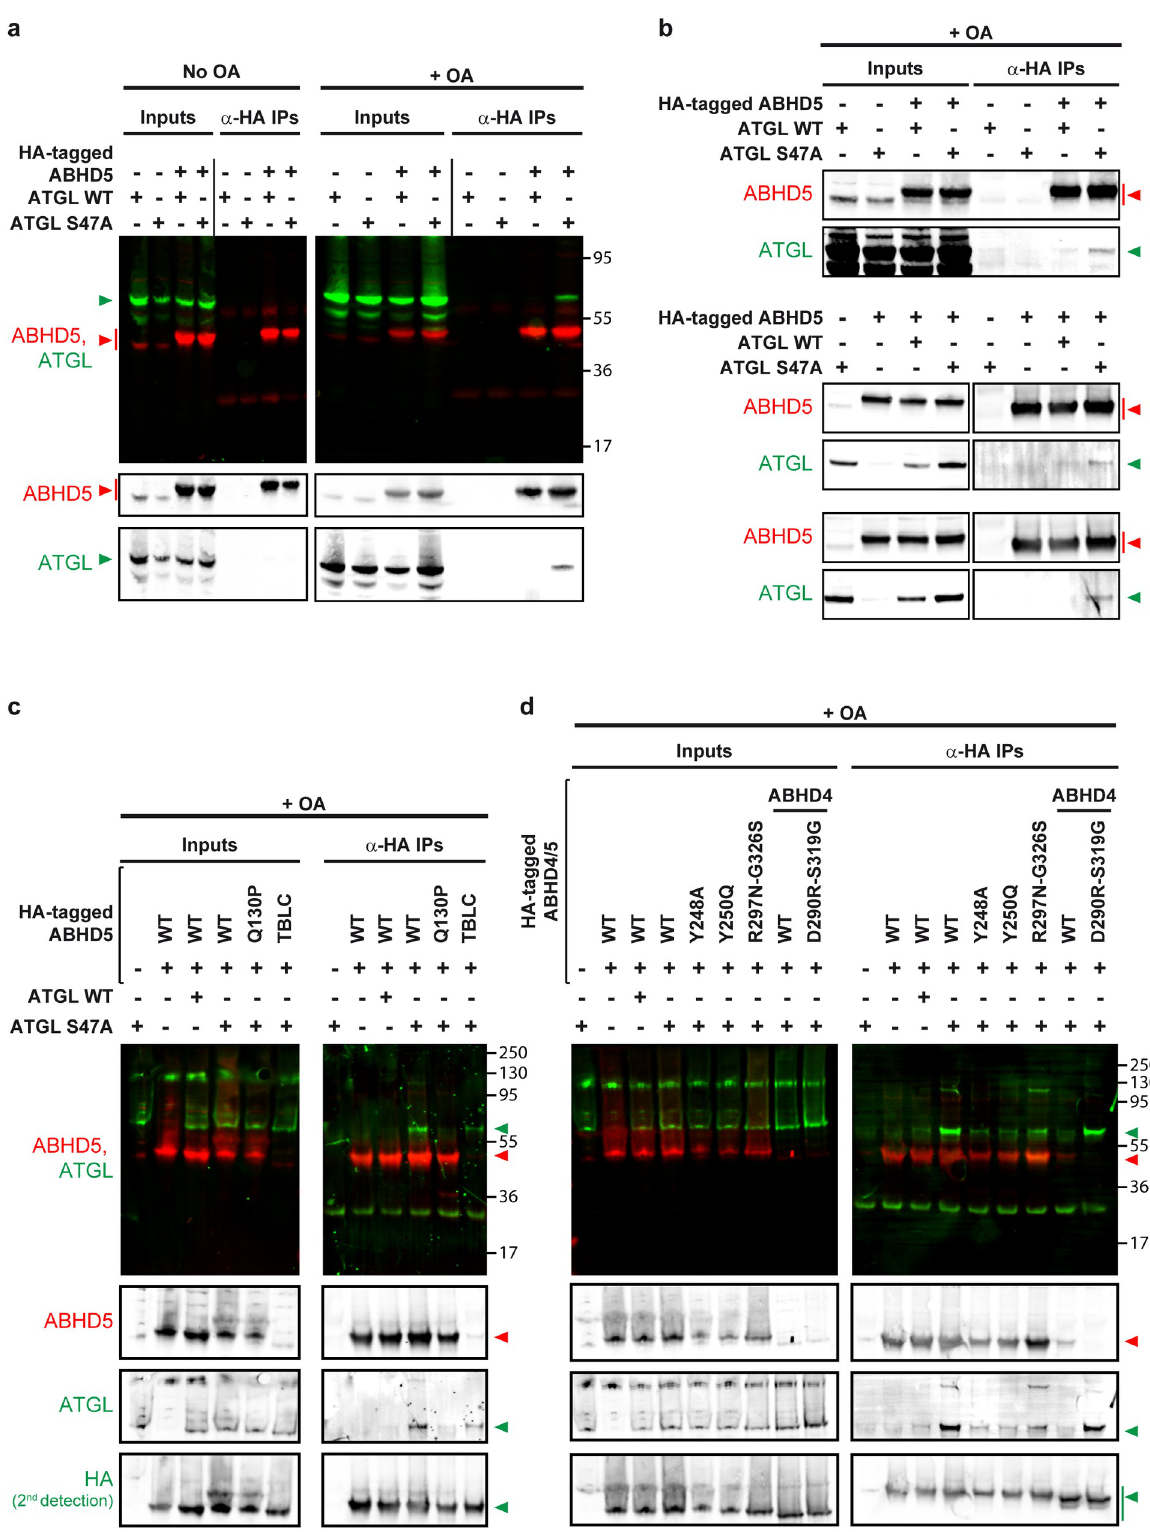
Fig 13. Interaction between ABHD5 and ATGL depends on ABHD5 residues R297 and G326. We transduced Lunet N hCD81 cells to co- express HA-tagged ABHD5 constructs and ATGL (WT or S47A) and harvested the cell lysates 48 hours post-transduction. We incubated